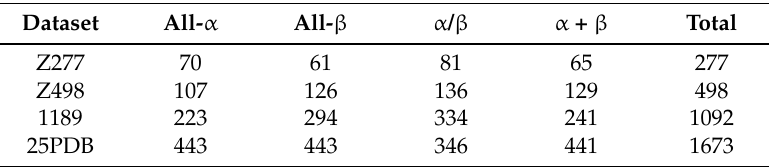
Table 6. The compositions of four datasets adopted in this study. Dataset All-